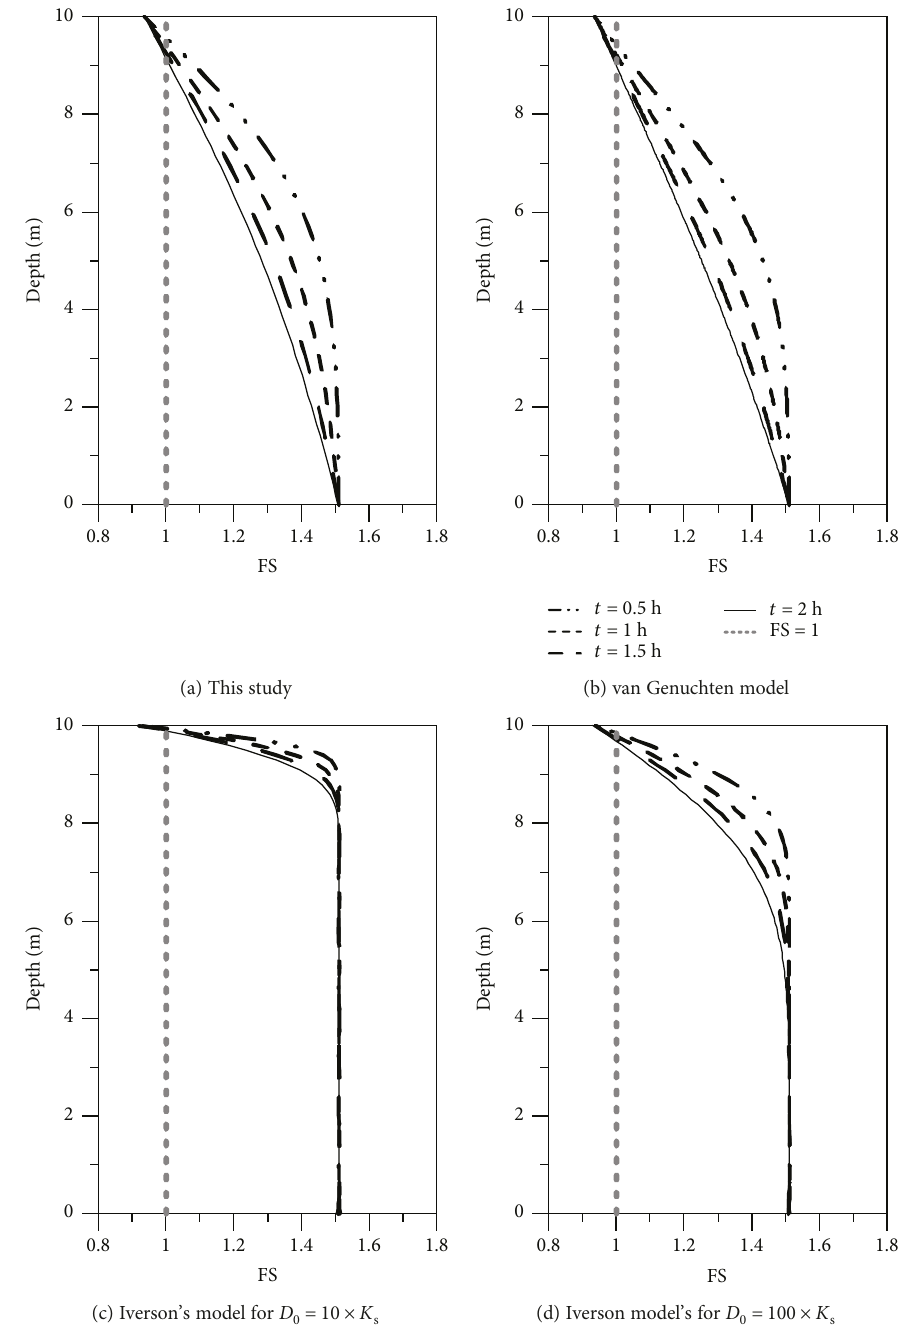
Figure 14: Comparison of the computed FS